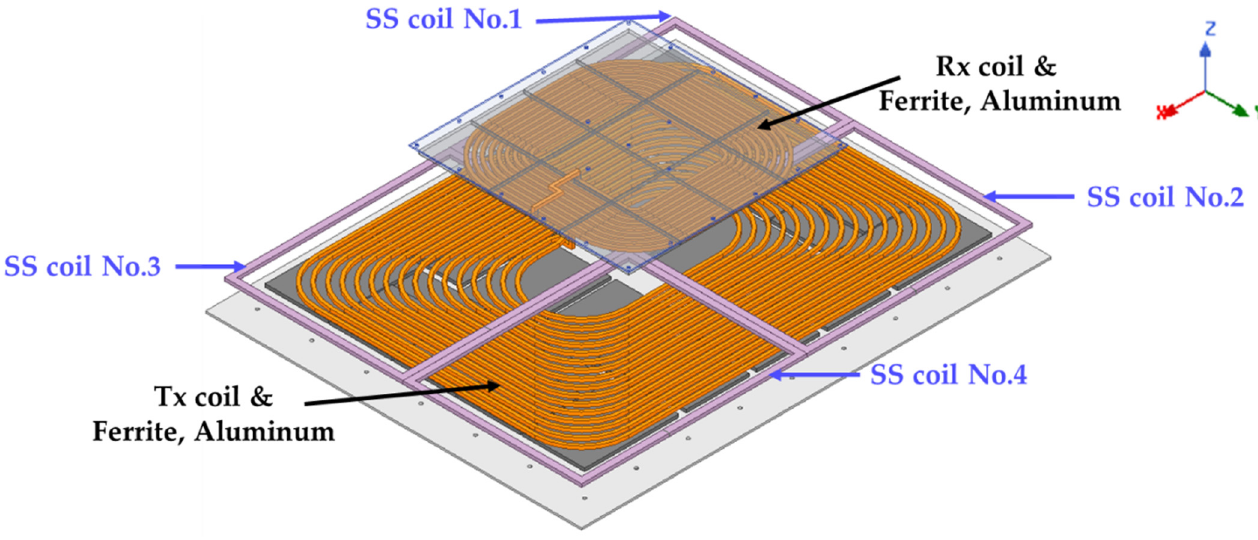
Figure 7. SAE J2954 WPT3/Z2 model with the SS coils.